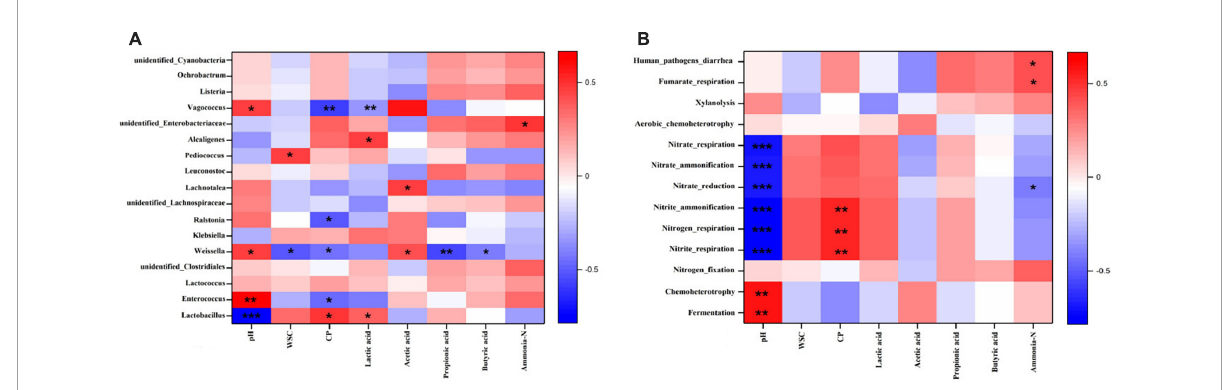
FIGURE4 Heatmap of Spearman correlations between bacterial community (A) predicted functions (B) and silage characteristics of 60-day Saccharum arundinaceum silage. Heatmap colors denote the Spearman correlation coefficient “ r ” (–1 to 1). r > 0 represents a positive correlation, and r < 0 represents a negative correlation. The asterisks *, **, and *** represent statistical significance levels of P < 0.05, < 0.01 and < 0.001,